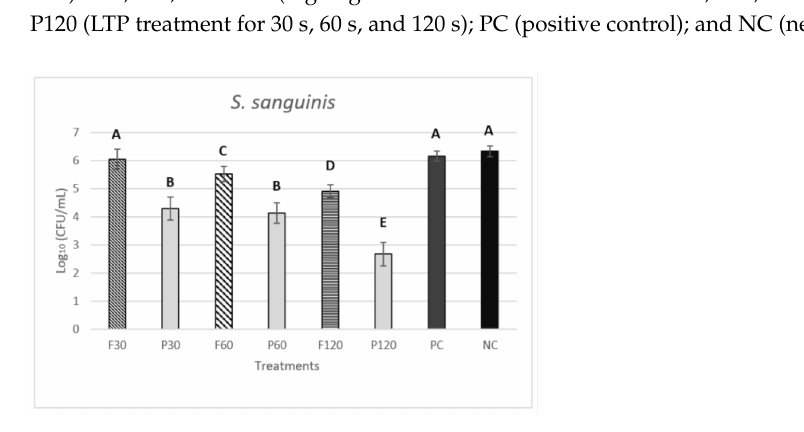
Figure 4. Mean values and standard deviations log 10 CFU/mL of single-species biofilms composed of S. sanguinis treated with LTP, 0.12% chlorhexidine (positive control), or 0.89% saline solution (negative control). Different letters indicate significant statistical difference (n = 9; p ≤ 0.05; ANOVA, Tukey’s Test). F30, F60, and F120 (argon gas—flow control treatment for 30 s, 60 s, and 120 s); P30, P60, and P120 (LTP treatment for 30 s, 60 s, and 120 s); PC (positive control); and NC (negative